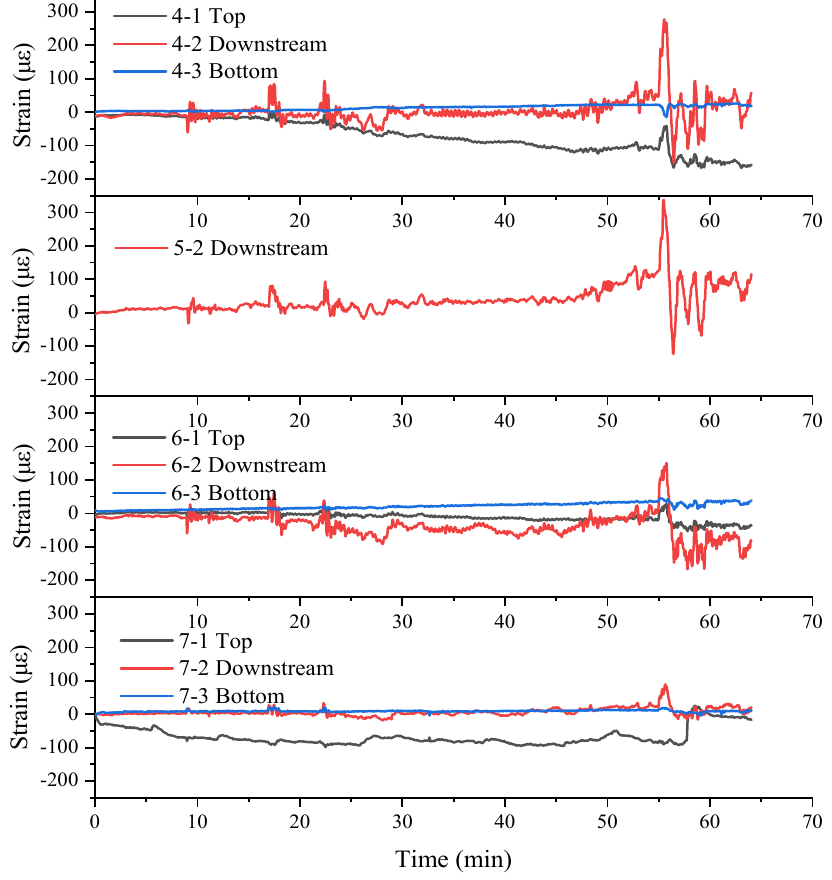
Figure 9. Pipeline Section 2 floating strain.